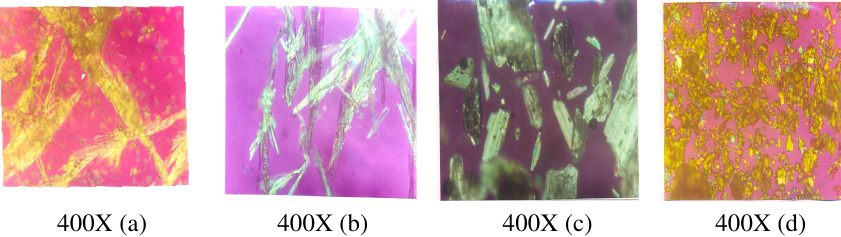
Figure 6 . Microphotograph of trees / bushes like pattern material along with microphotographs of succinic acid and ceric ammonium sulphate. (a) & (b) = pattern material, (c) = succinic acid, (d) = ceric ammonium